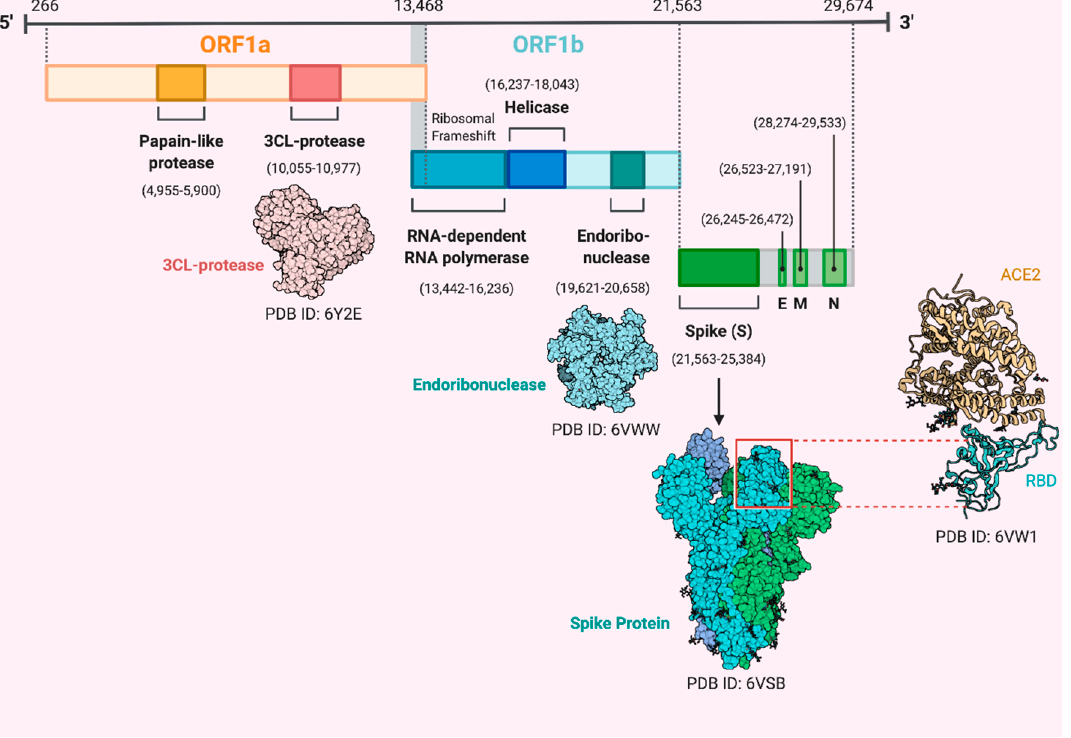
Figure 2. Genomic organization of severe acute respiratory syndrome coronavirus 2 (SARS-CoV-2), including open reading frames (ORF1a and ORF1b), spike (S), envelope (E), membrane (M), and nucleocapsid (N) proteins. Three-dimensional protein structures of 3CL-protease, endoribonuclease and spike protein bound to the human angiotensin converting enzyme 2 (ACE2) receptor are illustrated. PDB: Protein database.